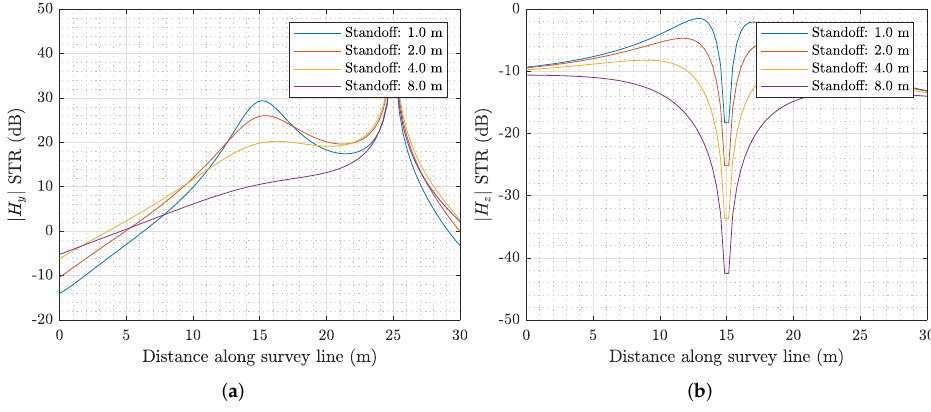
Figure 19. Absolute STR signal as a function of standoff distance. ( a ) | ∆ H y | . ( b ) | ∆ H z | .